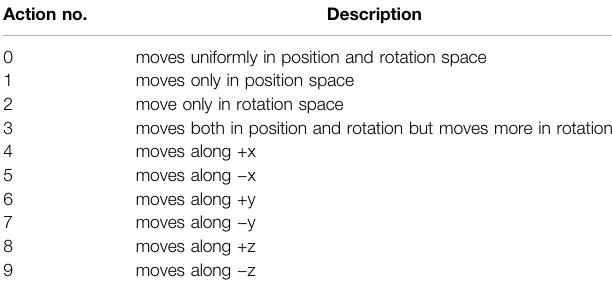
TABLE 1 | Discrete action space with their meanings. Action